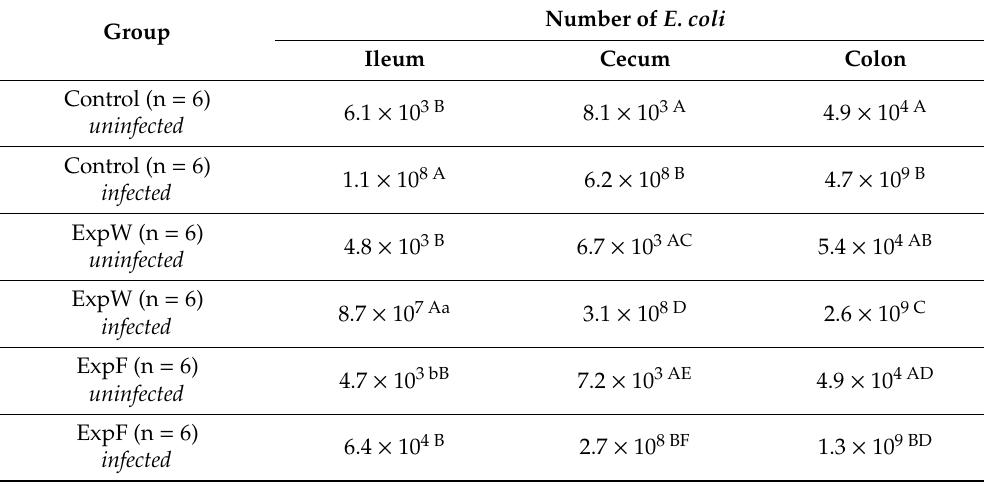
Table 7. E ff ect of herbs supplementations on number of E. coli in di ff erent part of gastrointestinal (cfu / g). Number of E. coli Group Ileum Cecum